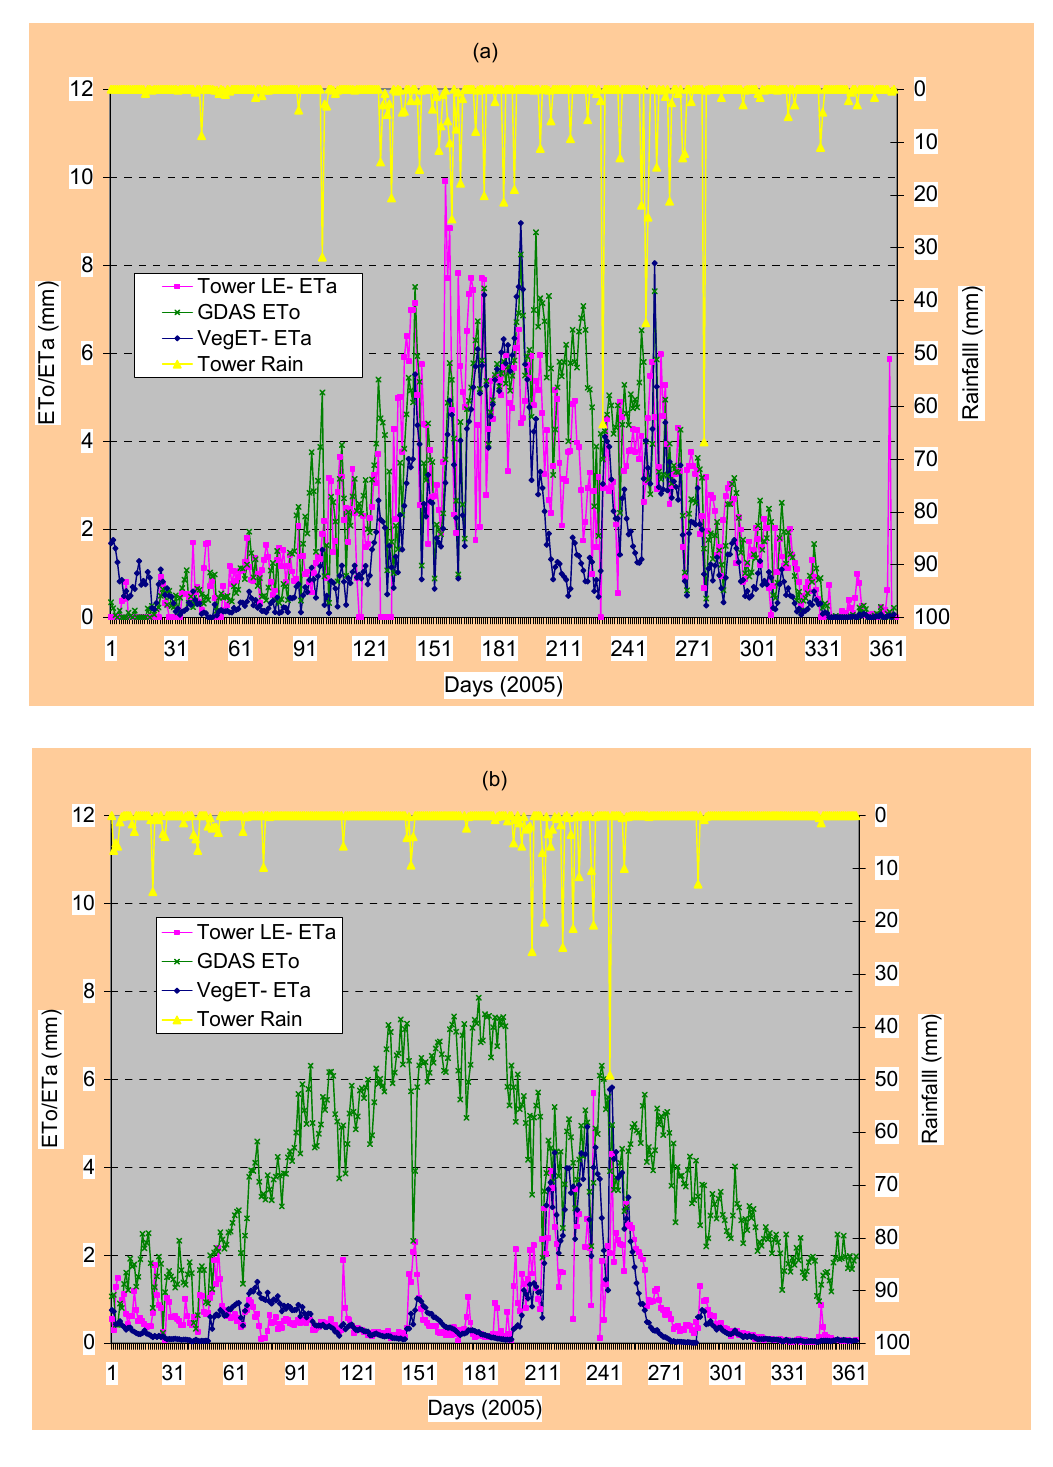
Figure 5. Validation of VegET ETa using AmeriFlux data in a grass/cropland region of Brookings, South Dakota (a) , and a semiarid grassland region of Audubon, Arizona (b) , using daily data from